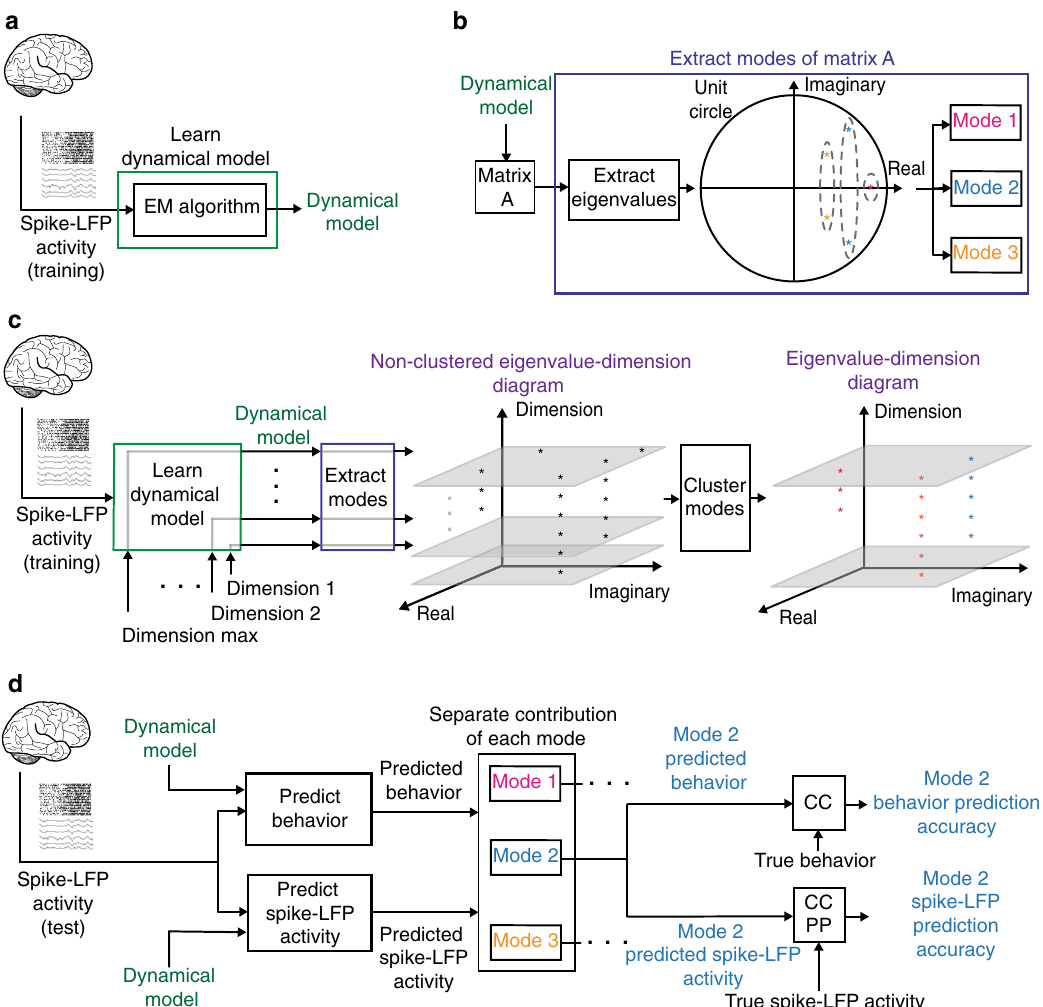
Fig. 2 Multiscale dynamical modeling and modal analysis. a We fi rst learn the dynamical model from the neural activity in the training set. The neural activity can be in the form of spiking, LFP, or combined spike-LFP activity. b After learning the dynamical model, we fi nd the principal modes